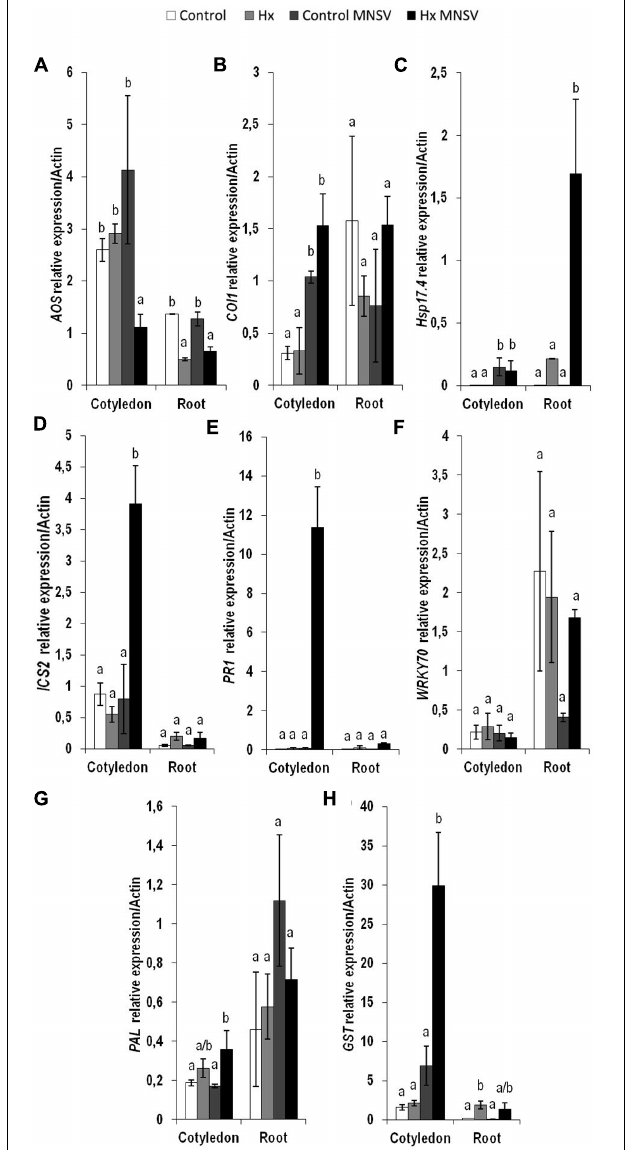
FIGURE 6 | Expression profile of the genes involved in plant defense pathways in the control and Hx-treated plants upon MNSV infection in early infection stages. Plants were grown and inoculated as described in Figure 2C . Total RNA was isolated from roots and leaves at 24 hpi, converted into cDNA and subjected to a qRT-PCR analysis. The results were normalized to the Actin gene expression level measured in the same sample. The expression levels of genes (A) AOS , (B) COI1 , (C) Hsp17.4 , (D) ICS2, (E) PR1 (F) WRKY70 , (G) PAL , and (H) GST were analyzed. Data represent the mean ± SE of three independent experiments with 10 plants per experiment. Letters indicate statistically significant differences between treatments at each time point ( p < 0.05; least significant difference